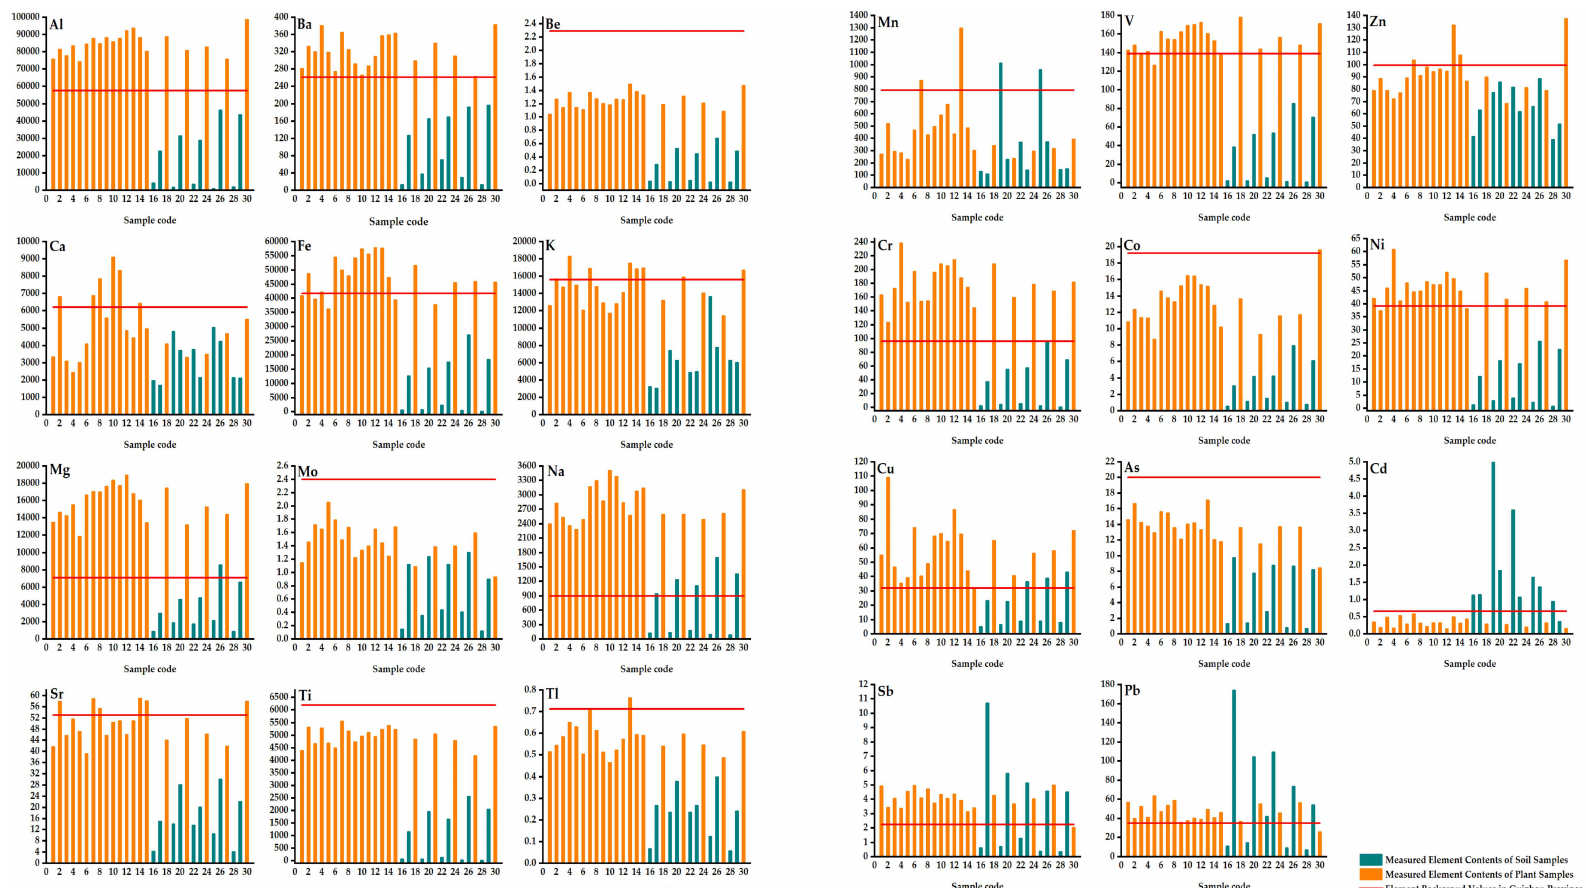
Figure 3. The contents and corresponding background values of 23 elements in 30 samples from Jiulongchi wetland (mg · kg − 1